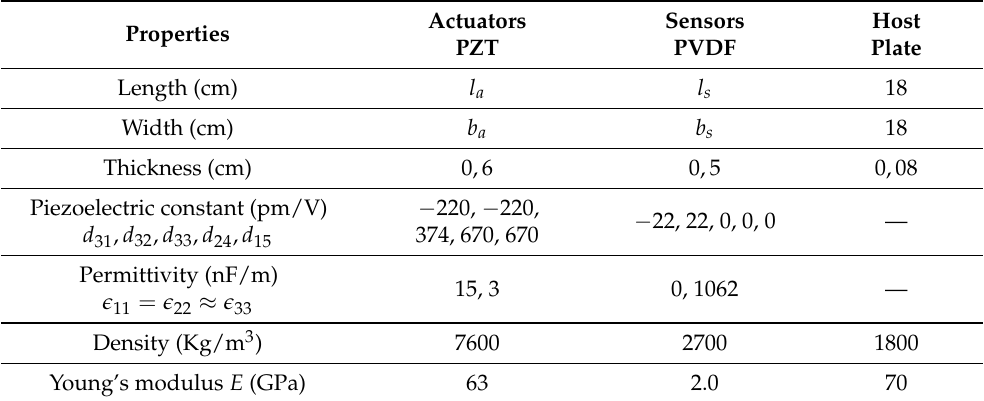
Table 1. Material properties of the piezoelectric elements and the host plate.